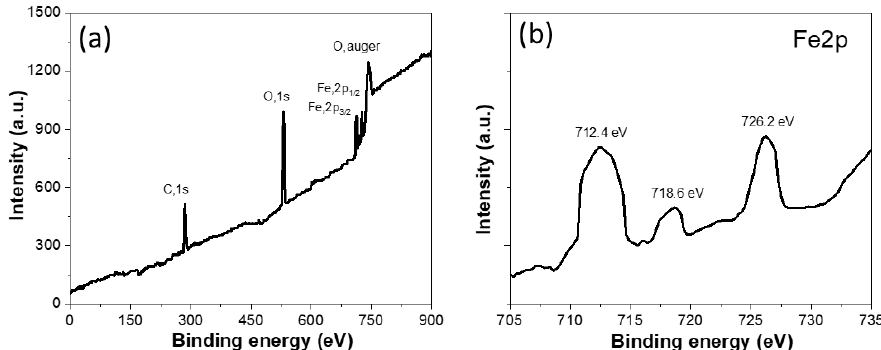
Figure 2. ( a ) XPS survey spectrum of the FeOOH/C composite, ( b ) high resolution Fe2p XPS of the FeOOH/C composite.